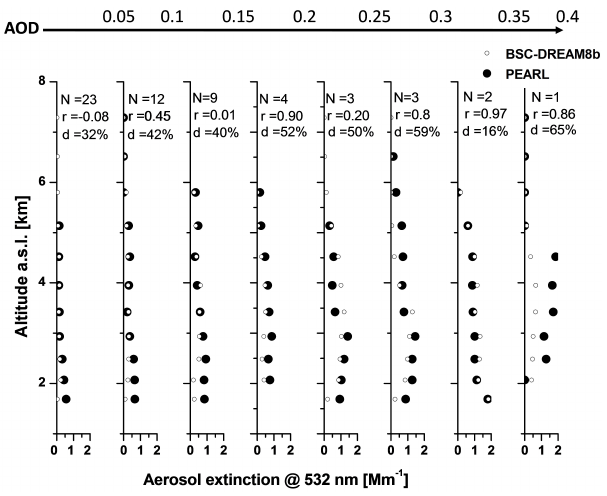
Figure 7. Lidar ratio values measured at 532nm inside the dust layer reported as a function of the Ångström exponent at 532/355nm. Data are reported following a color code based on rel- ative model–observation difference in aerosol extinction